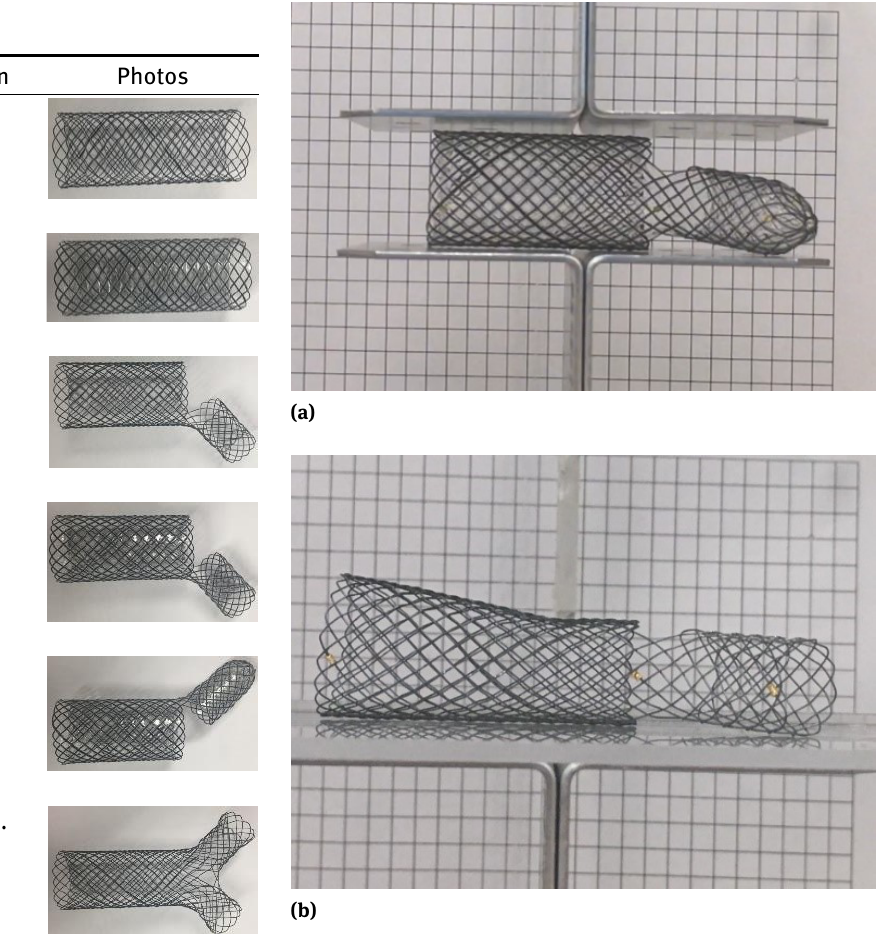
Figure 2: (a) Compression test, and (b) Indentation test of the